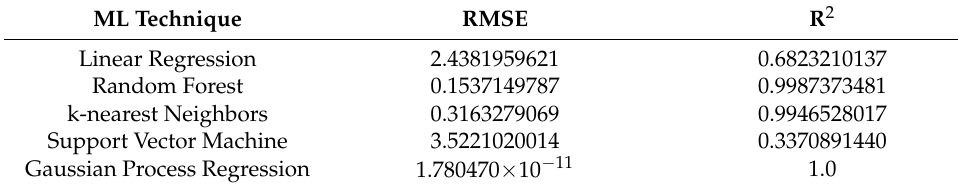
Table 9. SO2 results.